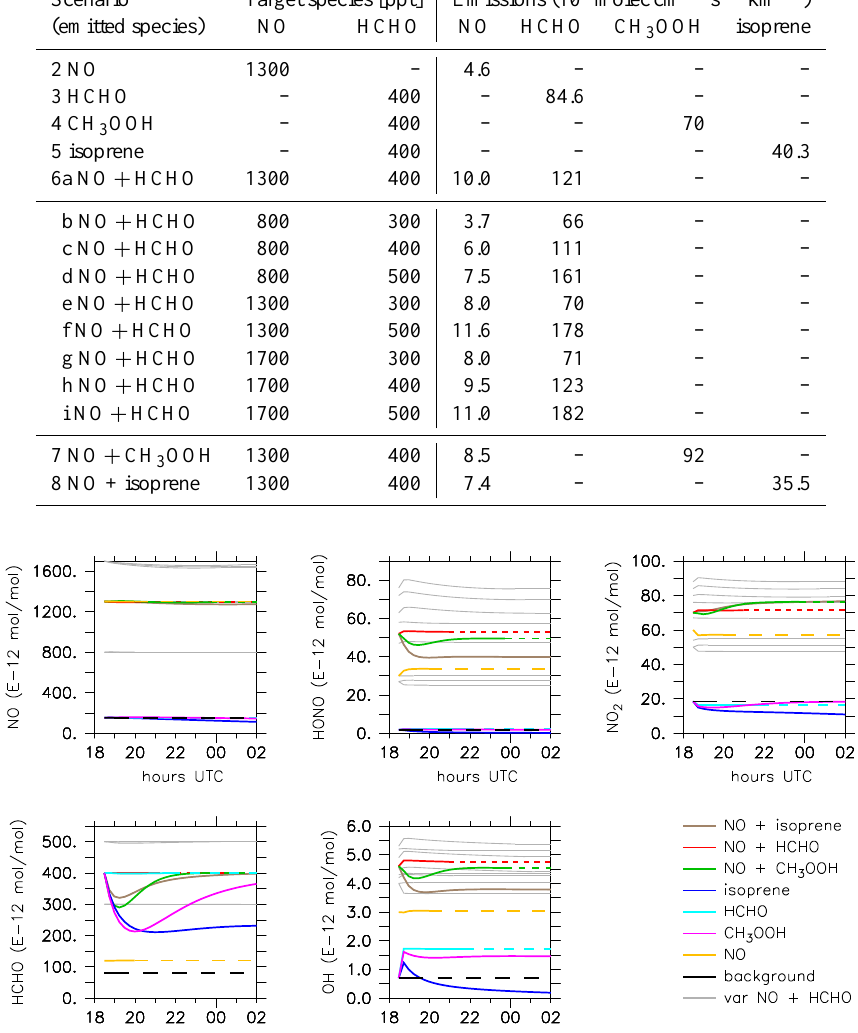
Figure 6. Simulated mixing ratios of NO, HONO, NO 2 , HCHO and OH as function of time for several emission (updraught) scenarios. The “+” sign in the legend denotes simultaneous emissions of both species. Grey lines show the variations of the NO + HCHO scenario (red line, scenarios 6b–i) with NO mixing ratios varying between 800 and 1700ppt (ppt = 10 − 12 molmol − 1 ), and HCHO mixing ratios varying between 300 and 500ppt. Dashed lines show at which level very short steady-state simulations end. The figures for HONO and NO 2 indicate that concomitant emissions of NO and one of the three VOCs enhance HONO and NO 2 mixing ratios more than any separate NO or VOC emissions. The separate low levels of HONO and NO 2 among the grey lines all belong to the scenarios with 800ppt NO.